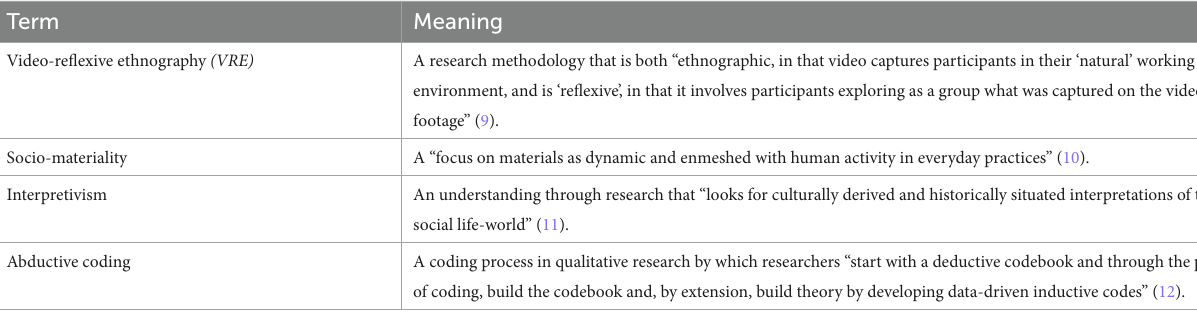
TABLE 1 Glossary of qualitative and theoretical terms.